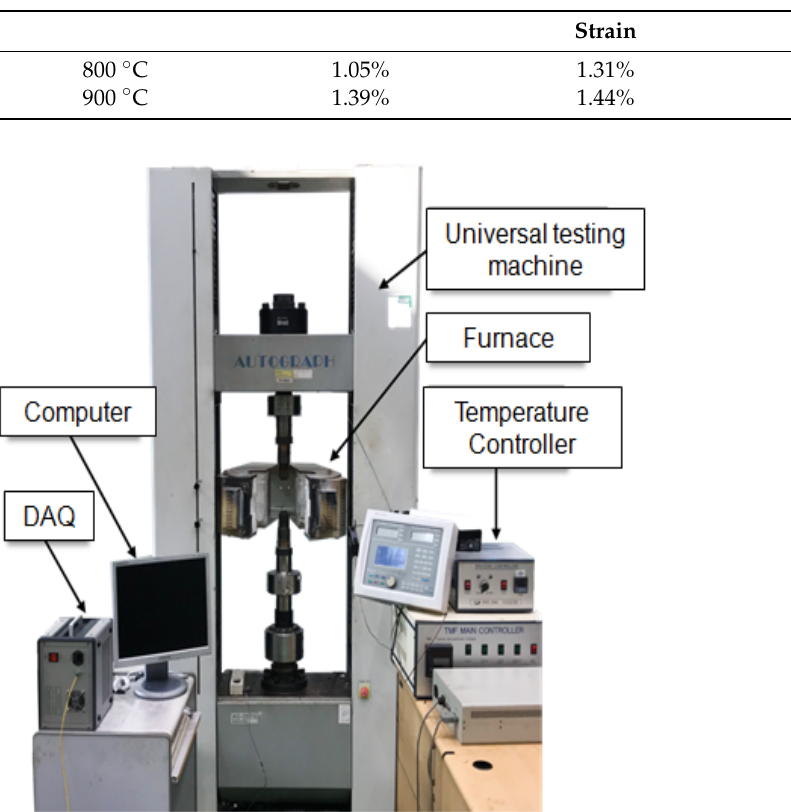
Table 2. Strain conditions during the low-cycle fatigue test.